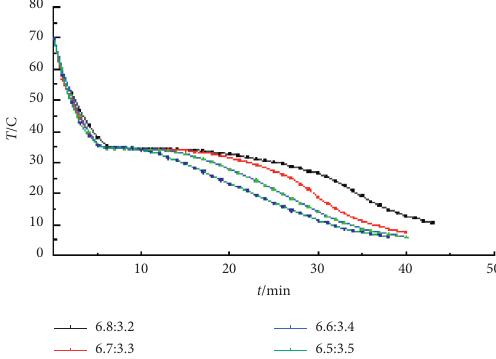
Figure 2: Step cooling curve of TD-MA binary composite phase change materials with different mass ratios near eutectic point.